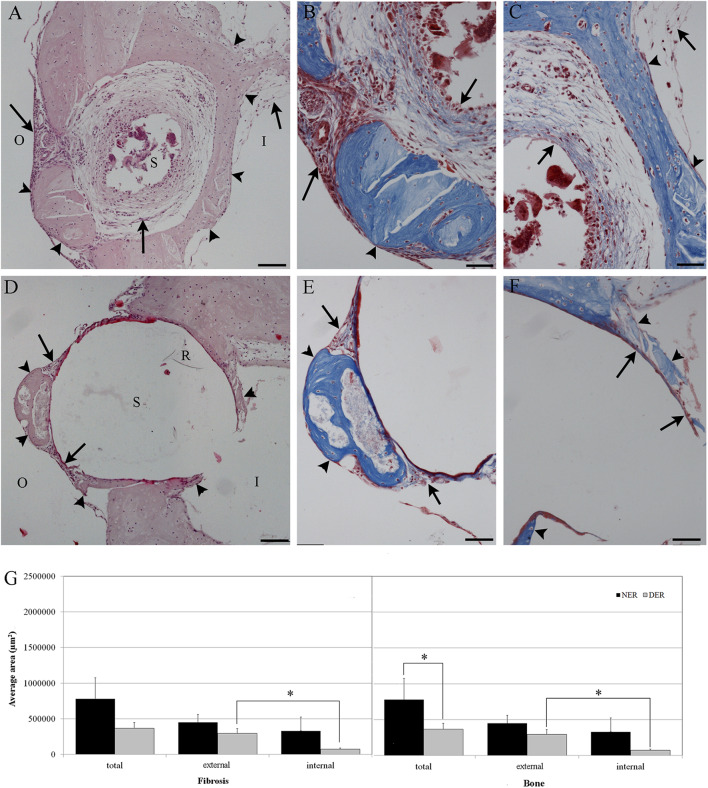
Cochleostomy sealing measured as tissue growth around the cochleostomy site after 60 days, according to treatment. (A,D) HEmatosillin-Eosin staining, (B,C,E,F) Masson's trichrome staining. (A–C) NER group. (D–F) DER group. (G) Bar graph represents the cochleostomy sealing expressed as areas (μm2) of fibrotic tissue and new bone growth around the cochleostomy site 60 days after surgery, according to treatment. Significant differences *p < 0.05. (A,D) Hematoxylin-eosin staining; scale bars, 100 μm. (B,C,E,F) Masson's trichrome staining; scale bars, 50 μm. I, inside cochleostomy; O, outside cochleostomy; S, rod site; R, silicon rod. Arrowheads, new bone growth; arrows, fibrotic tissue.